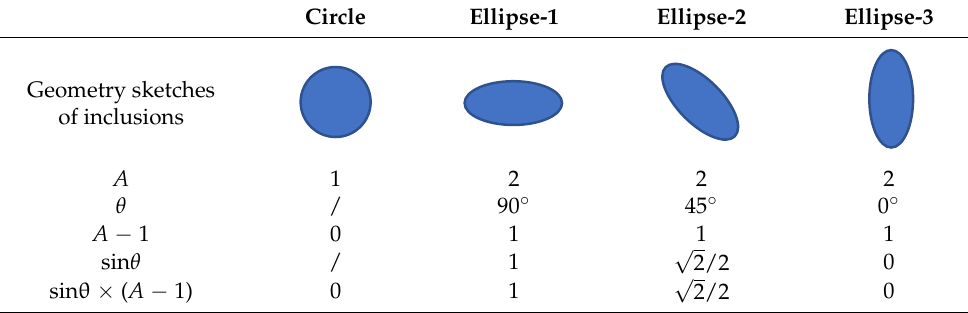
Figure 8. ( a ) The average fatigue life of different inclusions without the assistance of shape param- eter ξ ; ( b ) the variation of variance values of fatigue life with different inclusions caused by different RVEs.